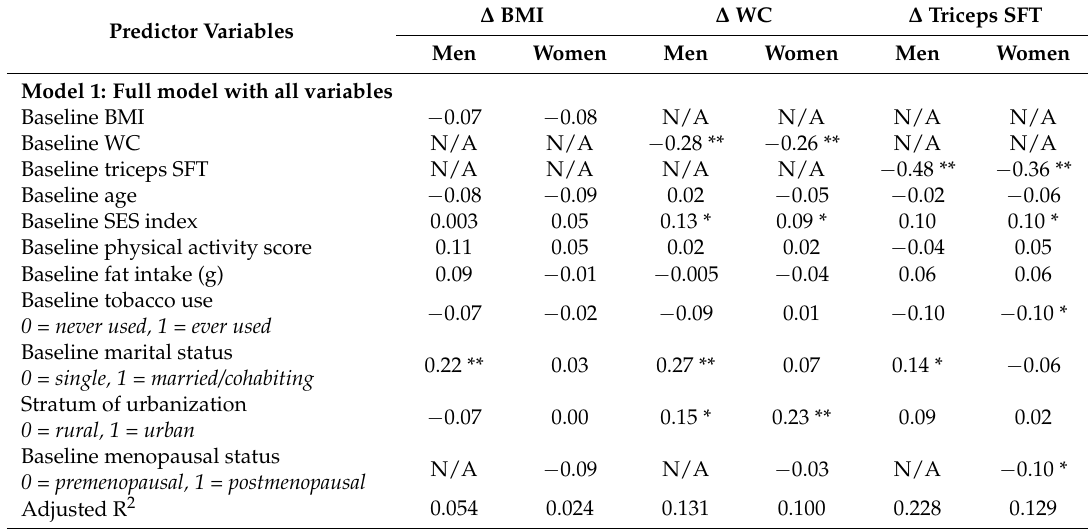
Table 4. Multiple regression analysis for the association between changes in adiposity variables ( ∆ BMI, ∆ WC, and ∆ triceps SFT in men and women, respectively) as dependent variables and predictor